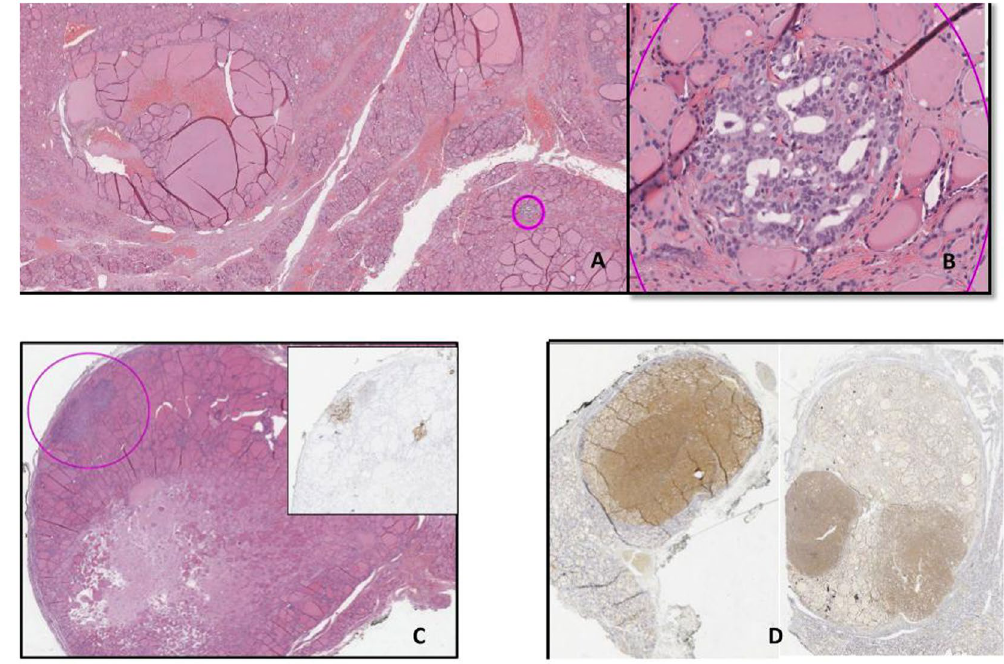
Figure 3. ( A , B ) Incipient (micro)NIFTP in the context con multinodular goiter (pink circle H&E, 4 and 20x). ( C , D ) The heterogeneous spectrum of multifocal NIFTP; ( C ) sprinkling phenomenon in multinodular goiter with HBME-1 correspective IHC staining (H&E 4x); ( D ) multifocal-bilateral NRAS q61r positive NIFTPs (IHC staining,